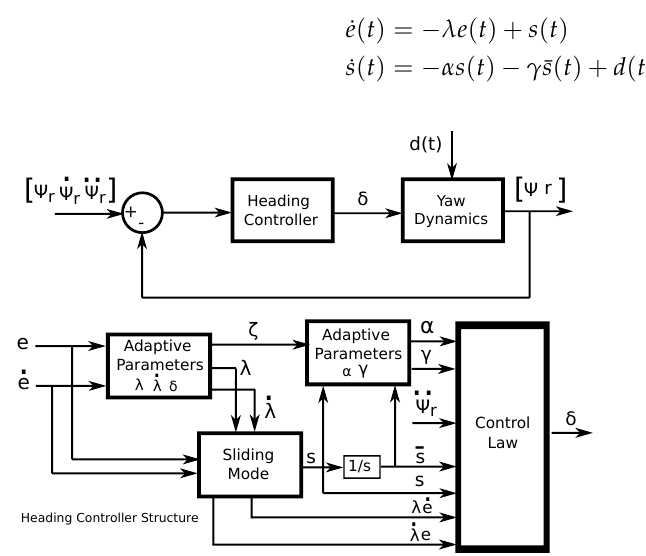
Figure 2. Course keeping control system and detail of heading control law block